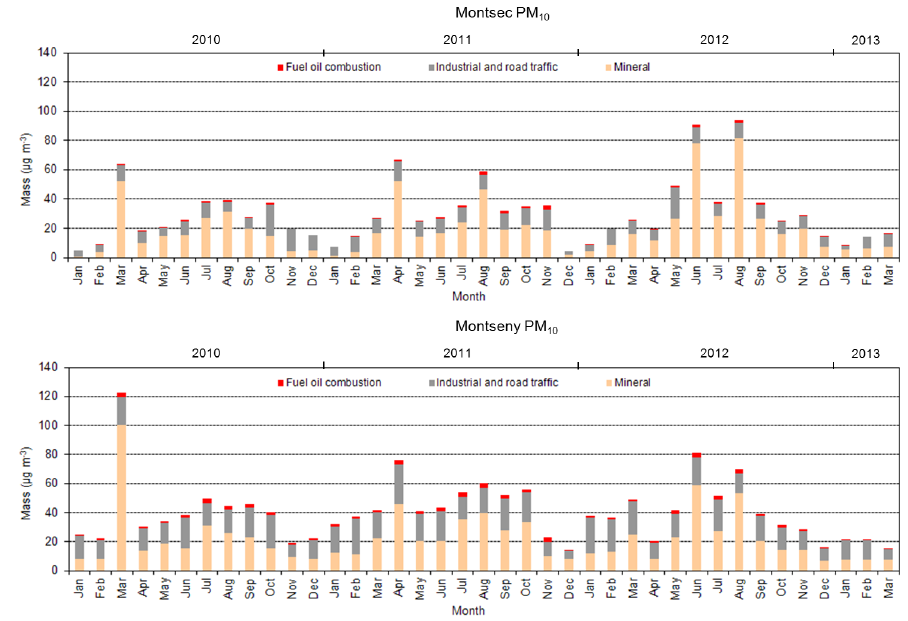
Figure 7. Monthly average concentrations of trace element groups at Montsec and Montseny based on daily measurements of PM 10 between January 2010 and March